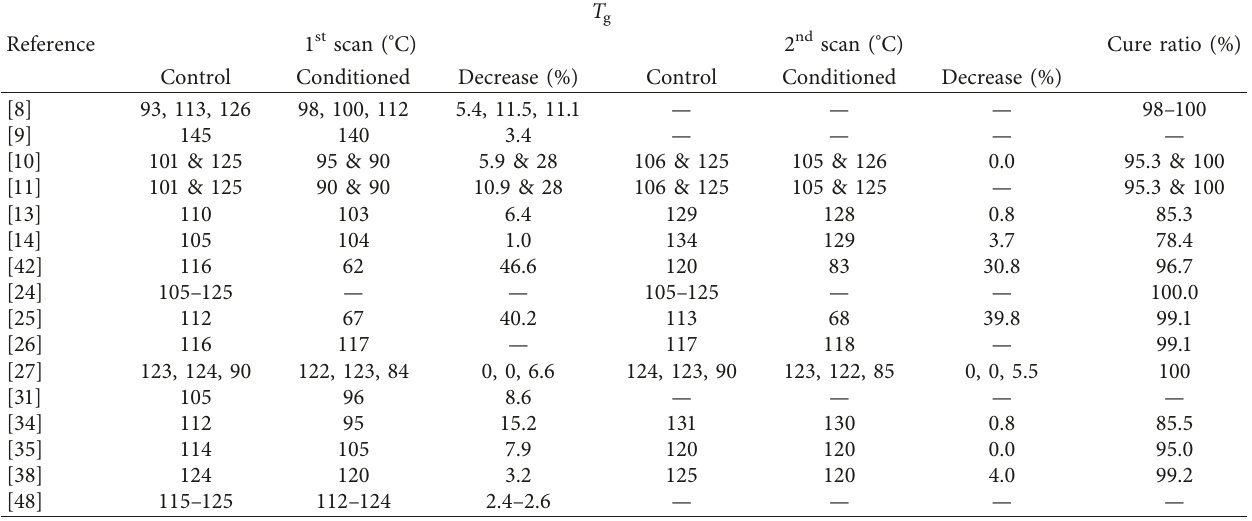
Table 11: Results of T g temperatures and cure ratio in control and conditioned GFRP reinforcing bars. Reference